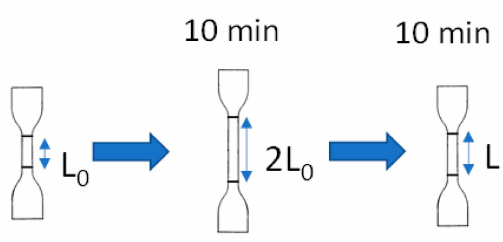
Figure A1. Test of tension